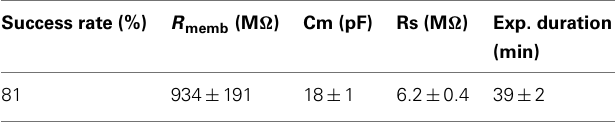
Table 2 | Success rate, cell parameters, and experiment duration for n = 87 HEK cells stably expressingTRPV3.